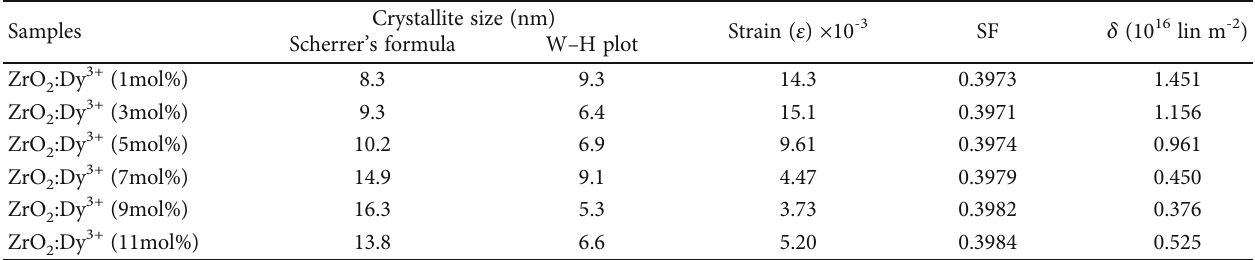
:Dy 3+ (1-11mol%) NPs. 2